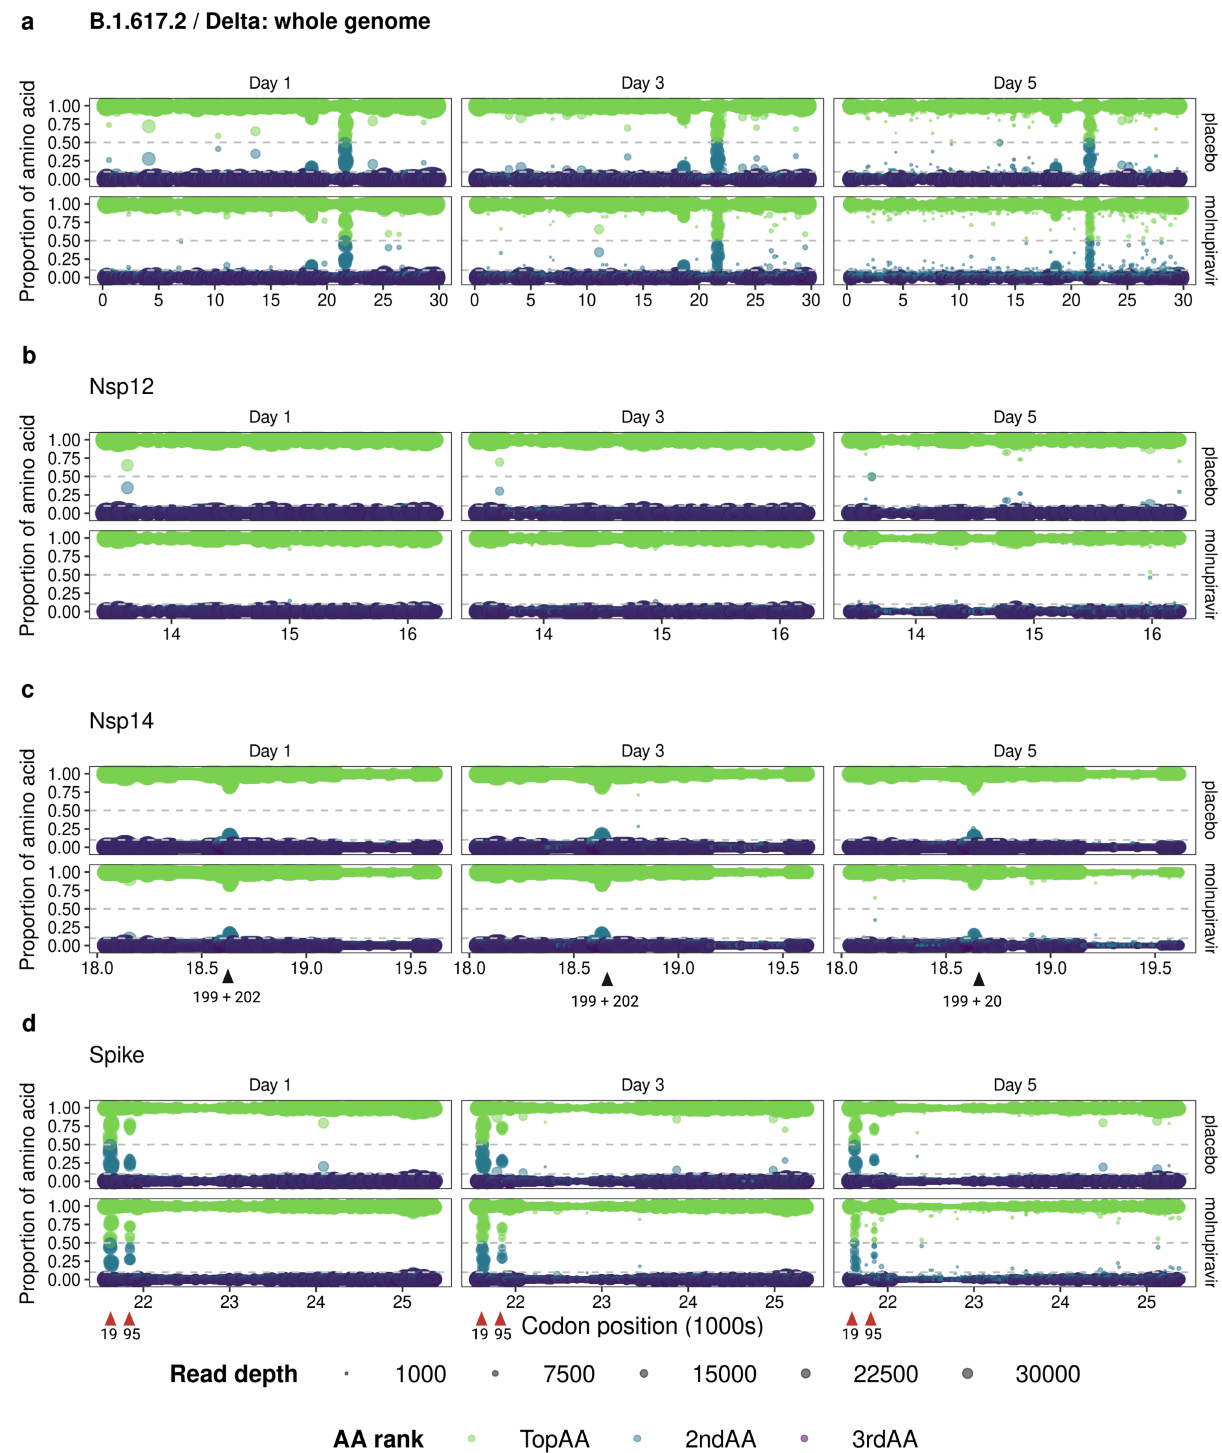
Fig. 2 | Predicted amino acid variations derived from SARS-CoV-2 RNA in the whole genome, NSP12, NSP14 and Spike sequences. a Predicted amino acid variation derived from RNA sequence information across the whole genome in all Delta infected participants ( n =52). Each sample is assigned a predicted “ Top ” (green), “ 2nd ” (blue) and “ 3rd ” (dark purple) amino acid (AA) based on proportion of reads at every genome position. Minimum read depth = 200. Minor genomic variants (>0.1 and <0.5; grey dashed lines) increase in frequency over time, with viral RNA from molnupiravir treated participants showing more diversity.